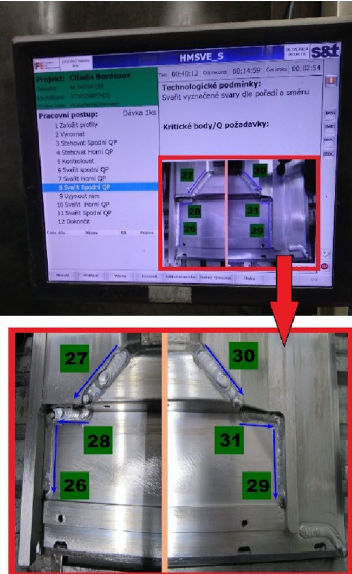
Figure 18. Monitoring of welding process.